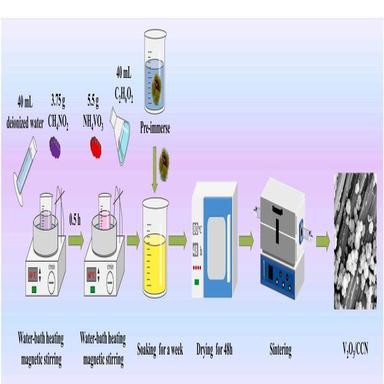
Schematic illustration of synthesis of V2O3/CCN composites.